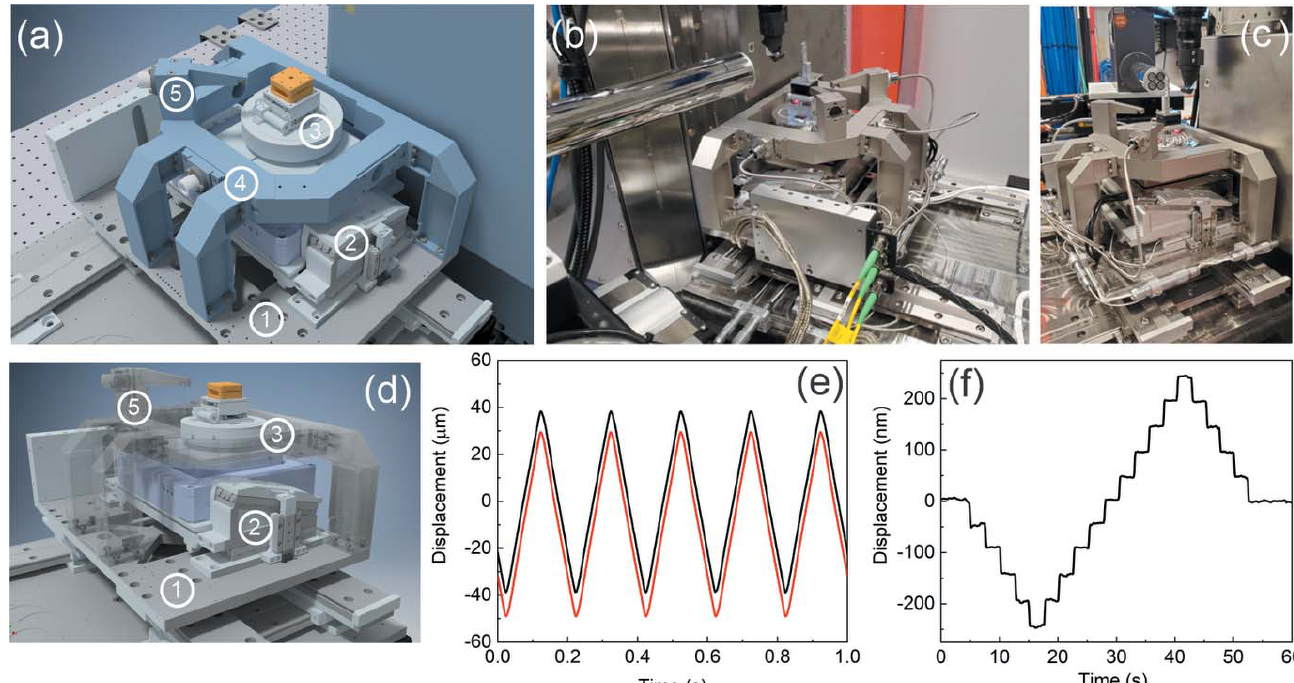
Figure 6 Overview and performance of the sample stage. Panels ( a ) and ( d ) show CAD models of the sample stage. The key components are enumerated: 1 – base long-travel-range X , Z stage; 2 – high-load vertical stage; 3 – scanner/rotary stage assembly; 4 – Invar reference frame; 5 – laser interferometry system. Panels ( b ) and ( c ) are photographs of the sample stage installed at the SRX beamline. Panel ( e ) shows a comparison between a 5 Hz raster scan encoded by the built-in scanner encoder (black line) and the external laser interferometer (red line). The interferometer readings are offset for clarity. Panel ( f ) shows a 50 nm step-scan performed at the beamline; the background noise level does not exceed 5 nm peak-to-peak